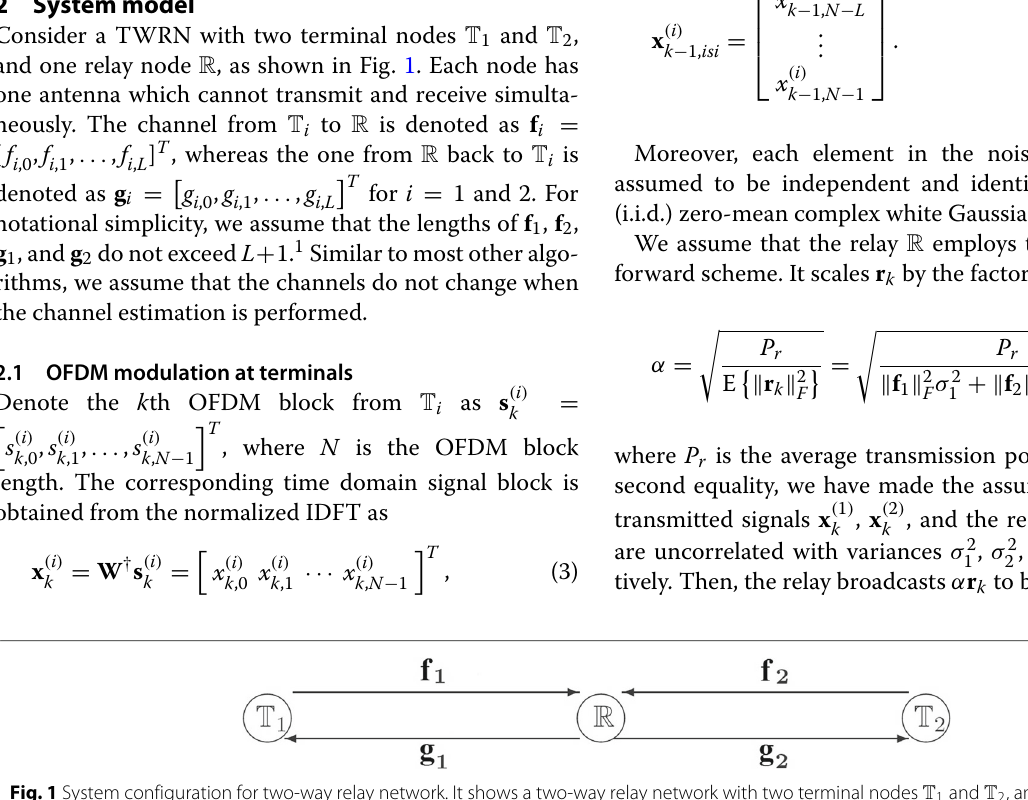
R is denoted as f i to i , whereas the one from